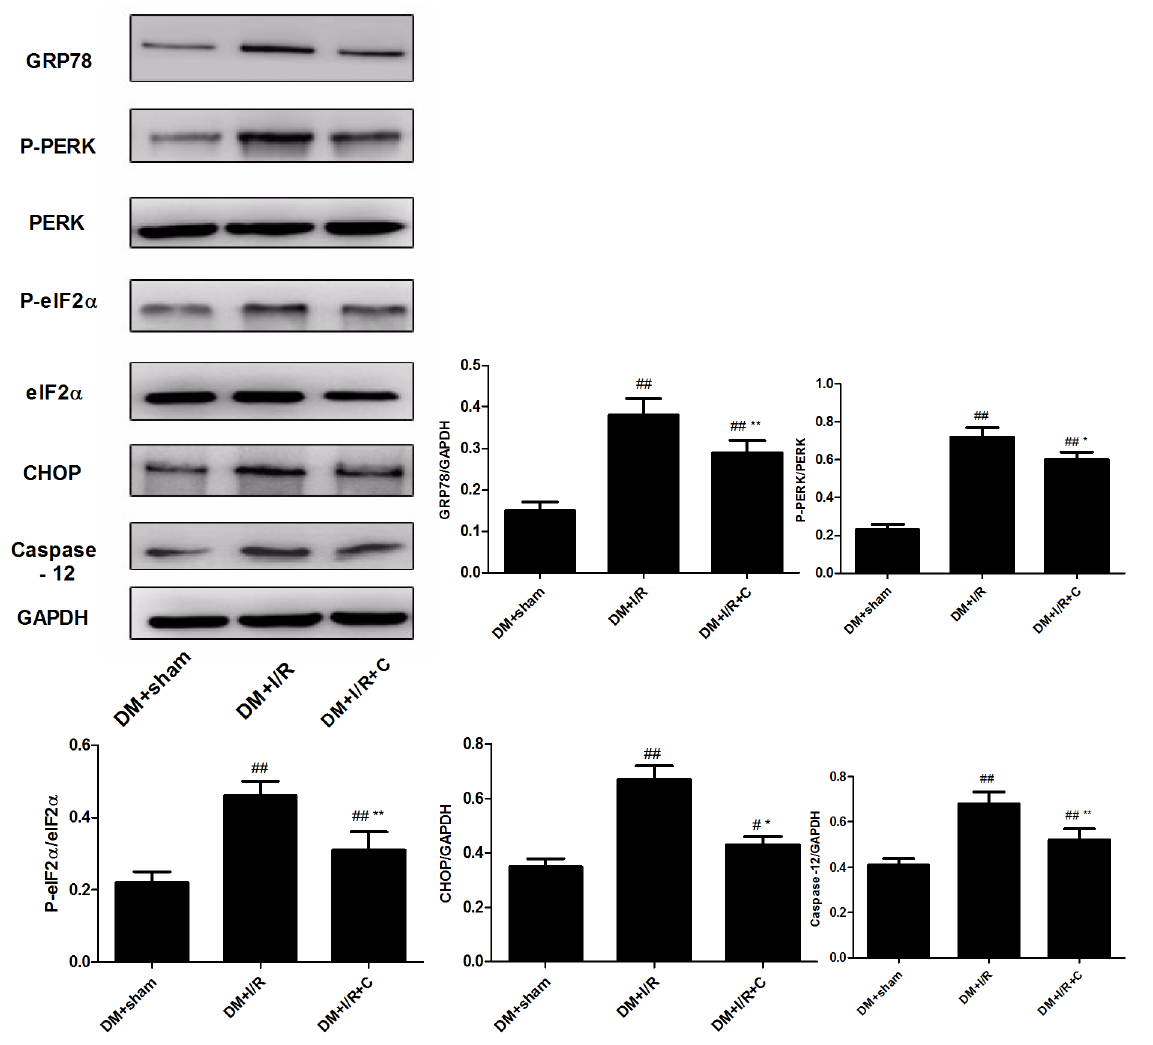
Figure 9. Effects of catalpol on expression of ERS-associated protein in diabetic myocardial tissues. # P < 0.05 versus the DM+sham group. ## P < 0.01 versus the DM+sham group; * P < 0.05 versus the DM+I/R group; ** P < 0.01 versus the DM+I/R